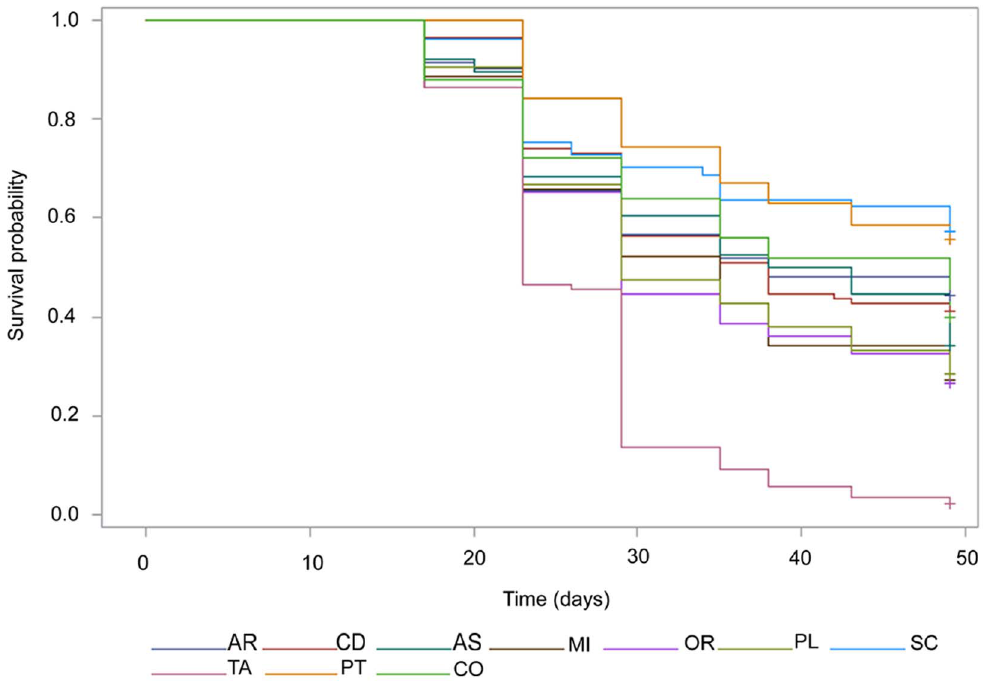
Fig. 2. Survival function for the event of wilting by populations of P. pinaster plants inoculated with F. circinatum at time 0 and estimated by the Kaplan-Meier method (2013